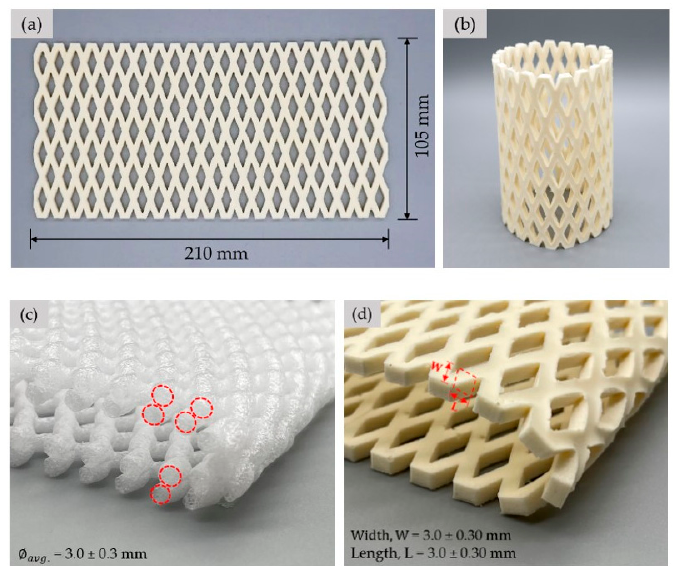
Figure 4. Fabrication and design of NRL-FN: ( a ) foam net sheet; ( b ) foam net cylindrical tube; ( c ) cross-section of EPE-FN; and ( d ) cross-section of NRL-FN.